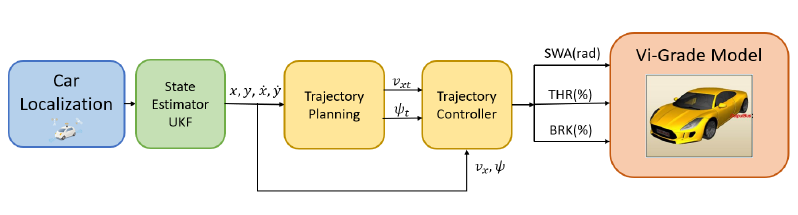
Figure 1. System architecture.